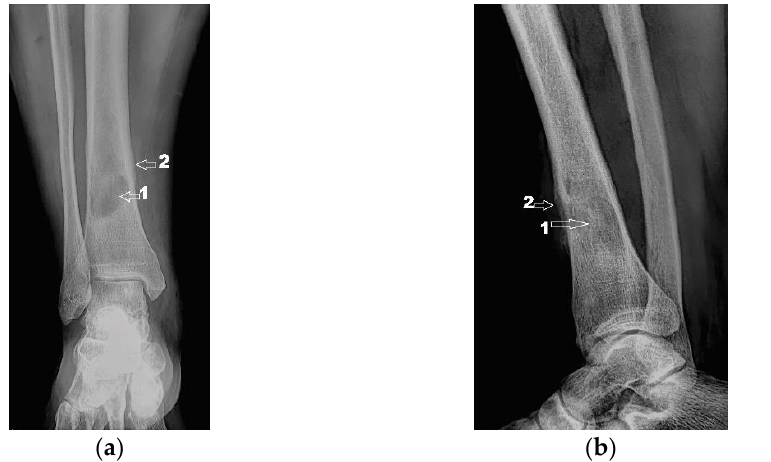
Figure 2. ( a ) Radiological image (coronal view); ( b ) Radiological image (lateral view). 1 — osteolytic lesion; 2 — periosteal reaction.